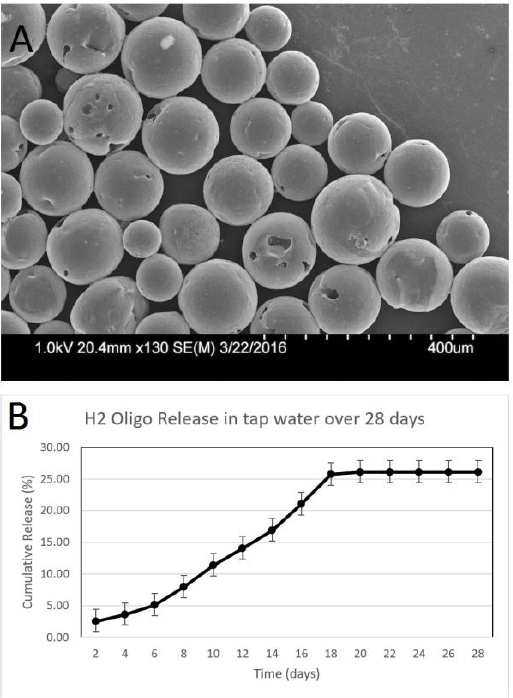
Figure 5. Characterization of H2 oligo-releasing microspheres. ( A ) Scanning electron microscopy images of microspheres. ( B ) Graph showing the cumulative release of the H2 DNA probe over 28 days representing the cumulative standard deviation at each time interval ( n = 3).